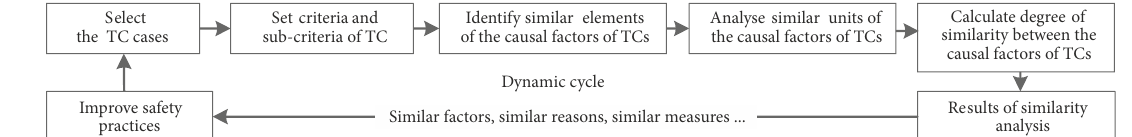
Figure 3. Research process of a similarity analysis of